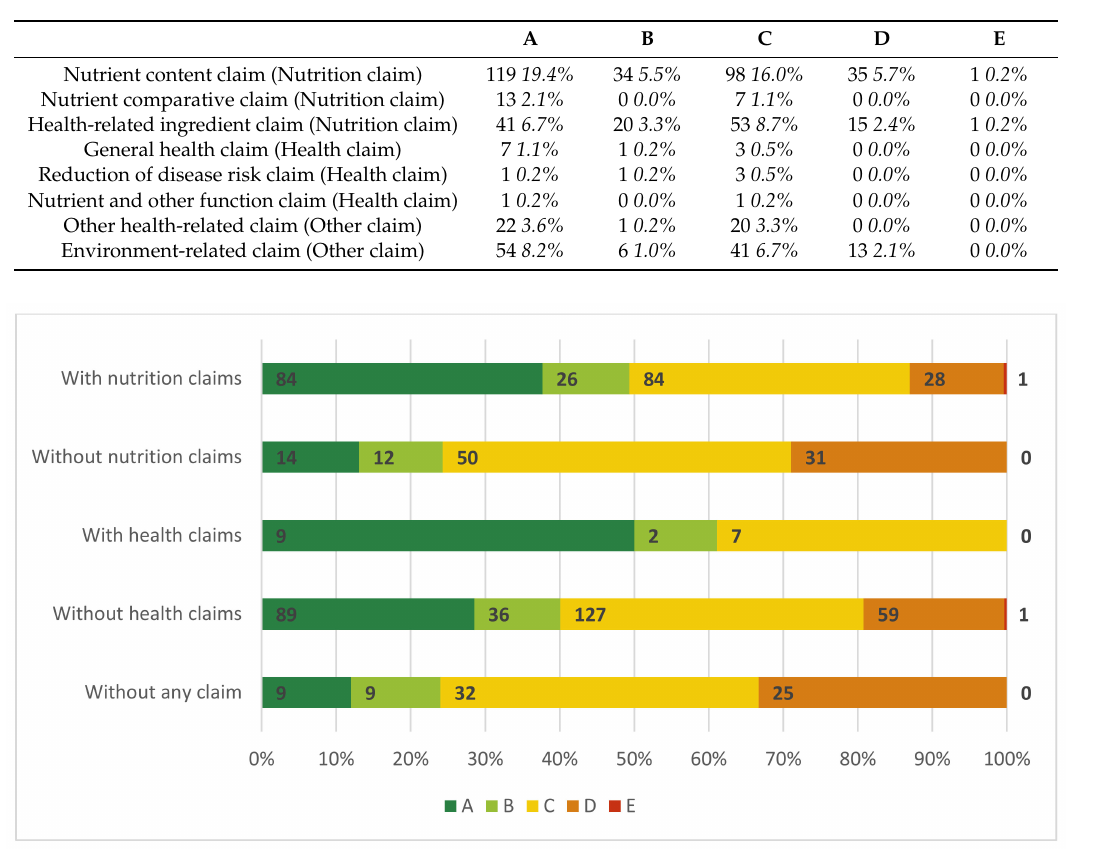
Table 2. Detailed overview of the different types of claims within each Nutri-Score category (A,B,C,D,E) (2018) .